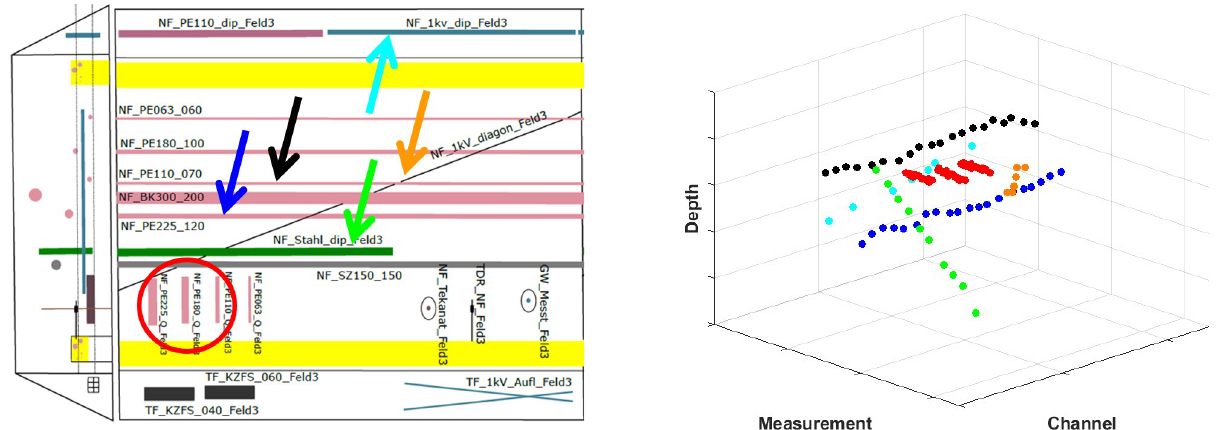
Figure 2 . Site plan of buried pipelines in the investigated part of the test site (left). Reference 3D map containing eight different pipes